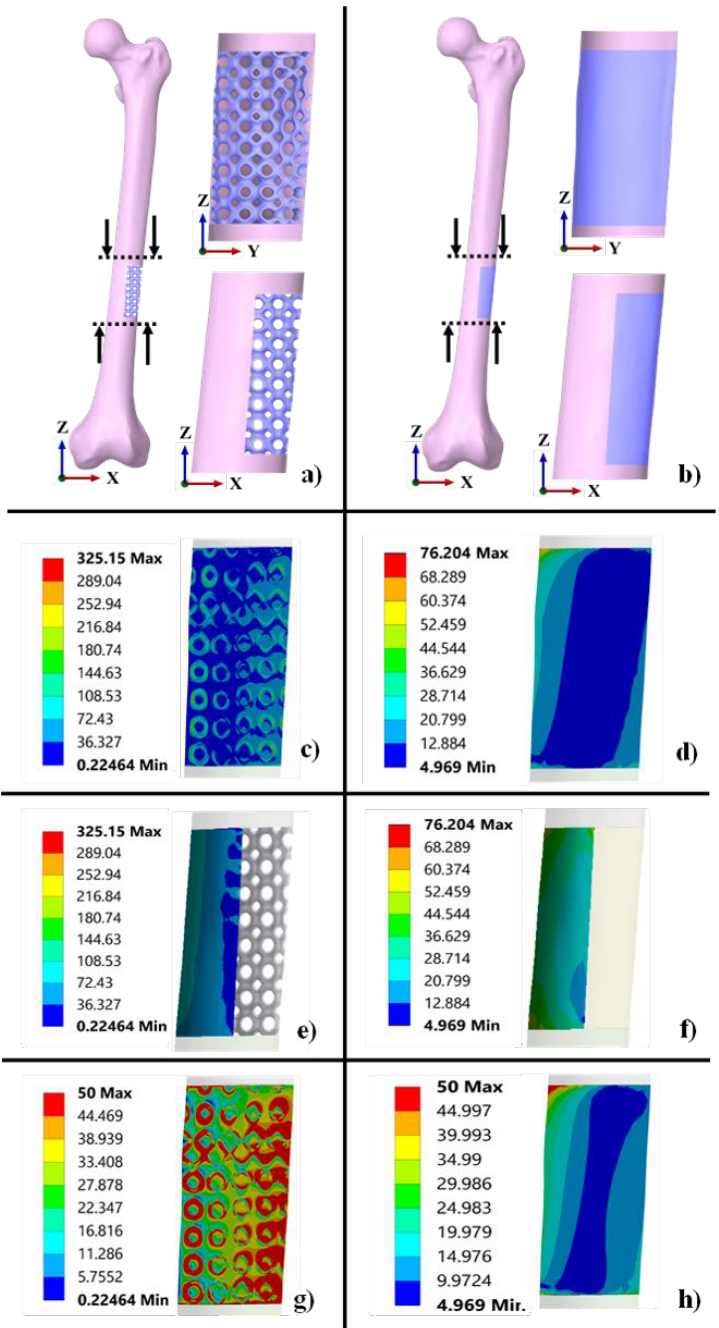
Figure 10. Biomechanical setup of the critical size bone defect with solid and porous scaffolds on femur bone to demonstrate the stress transfer patterns ( a ). The femur bone defect replaced with P lattice structures with 80% porosity (top right shows the enlarged lateral view and bottom right shows the front view illustrating the defect where bone fragments have contact [104]. ( b ) The femur bone defect replaced with solid scaffold. ( c ) Stress transmission pattern on the bone at P scaffold and bone interfaces after removing scaffold. ( d ) Stress transmission pattern on the bone at solid scaffold and bone interfaces after removing solid scaffold. ( e ) Von Mises stress patterns of bone with porous scaffold (Front view). ( f ) Von Mises stress patterns of bone with porous scaffold (Front view). A threshold of the maximum value of 50 MPa was set to visualize the stress concentration in the ( g ) Model with P scaffold and ( h ) Model with a solid